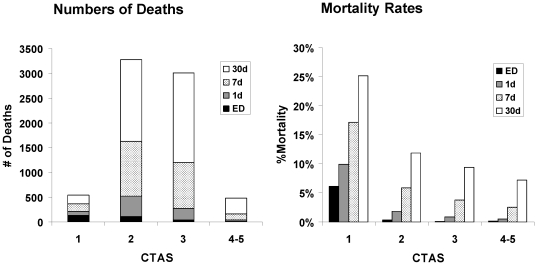
Cumulative number of ED-, 1-day, 7-day, and 30-day deaths (left), and corresponding mortality rates (right) by CTAS level.